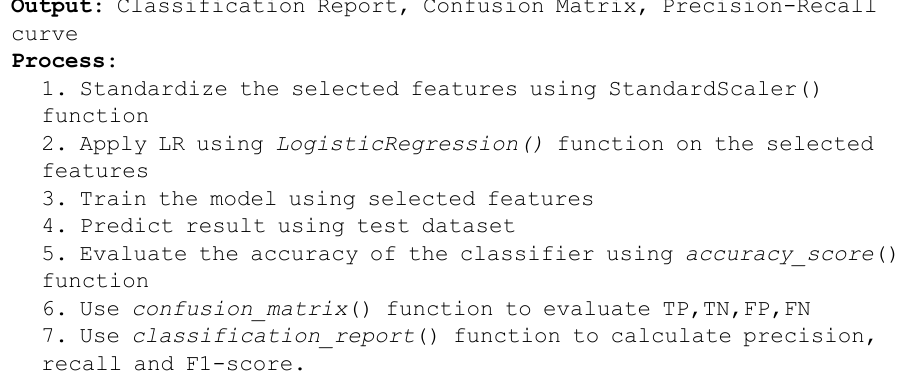
Algorithm 3. Abnormality detection using LR.